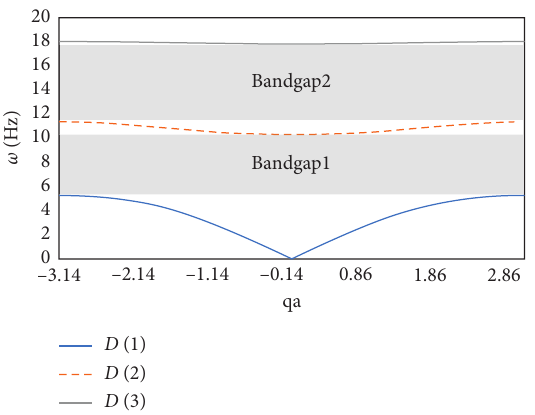
Figure 14: Dispersion curves for the 2DOF model.